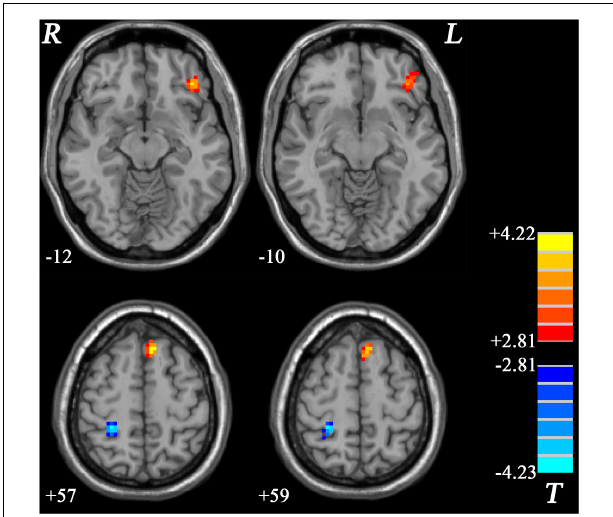
FIGURE 2 | Regions with significantly different PAS scores in comparison between GI-MDD and nGI-MDD patients without GI symptoms. The color bar indicates the T -values from post hoc t -tests. GI-MDD, major depressive disorder with gastrointestinal symptoms; nGI-MDD, major depressive disorder without gastrointestinal symptoms; PAS, parameter of asymmetry.